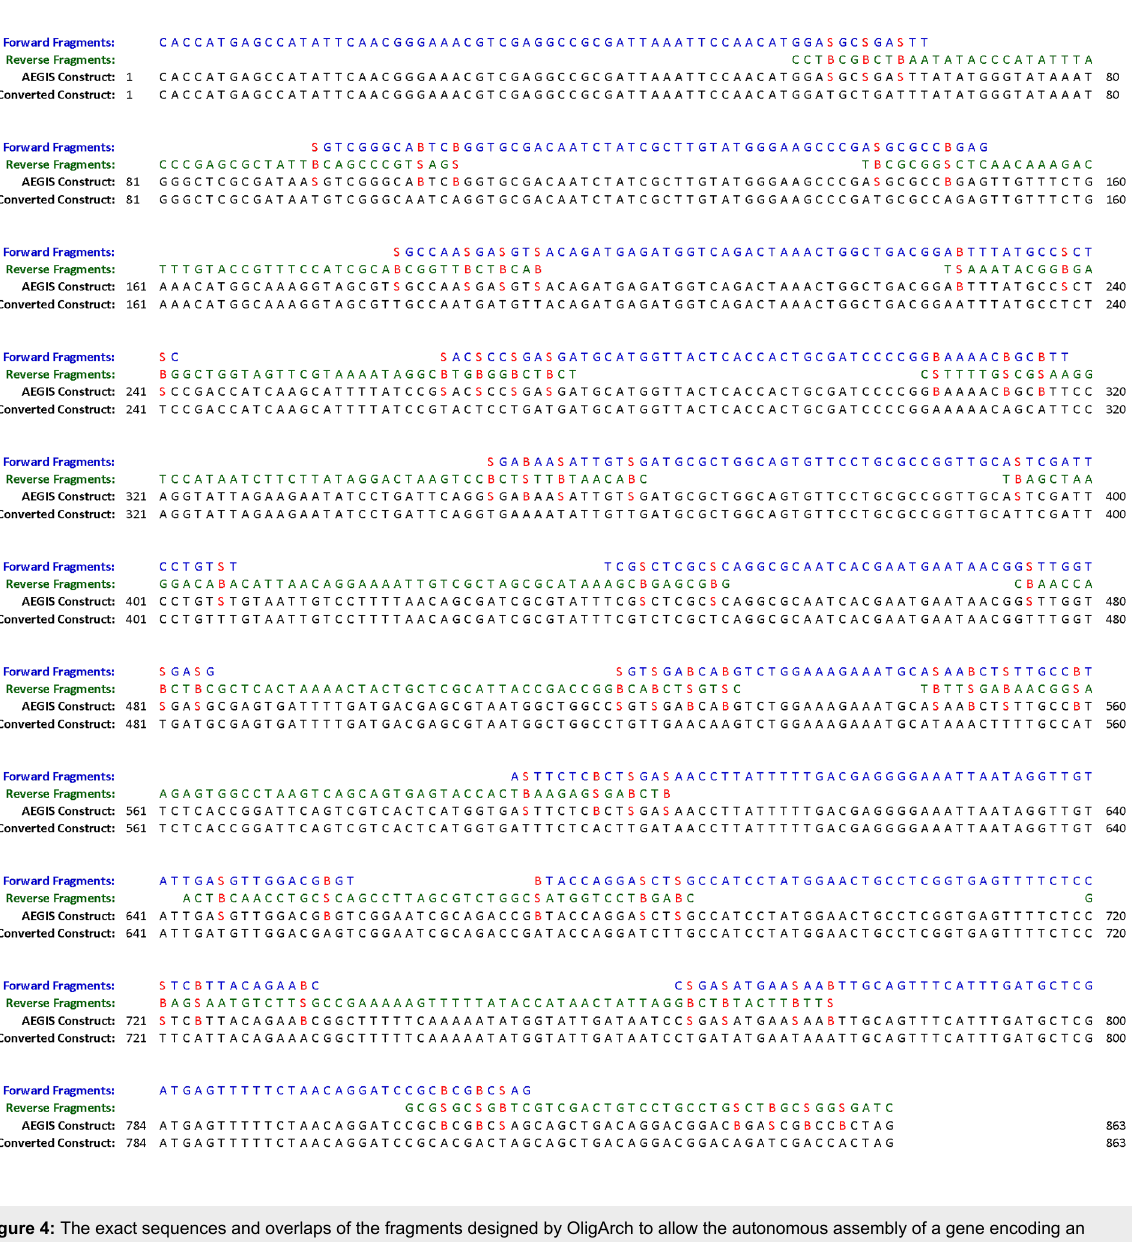
Figure 4: The exact sequences and overlaps of the fragments designed by OligArch to allow the autonomous assembly of a gene encoding an aminoglycoside 3’-phosphotransferase that confers upon E. coli resistance to kanamycin, aligned above the gene that arises via conversion PCR. The AEGIS nucleotides, S and B (red), were placed in the overlap regions to guide self-assembly.